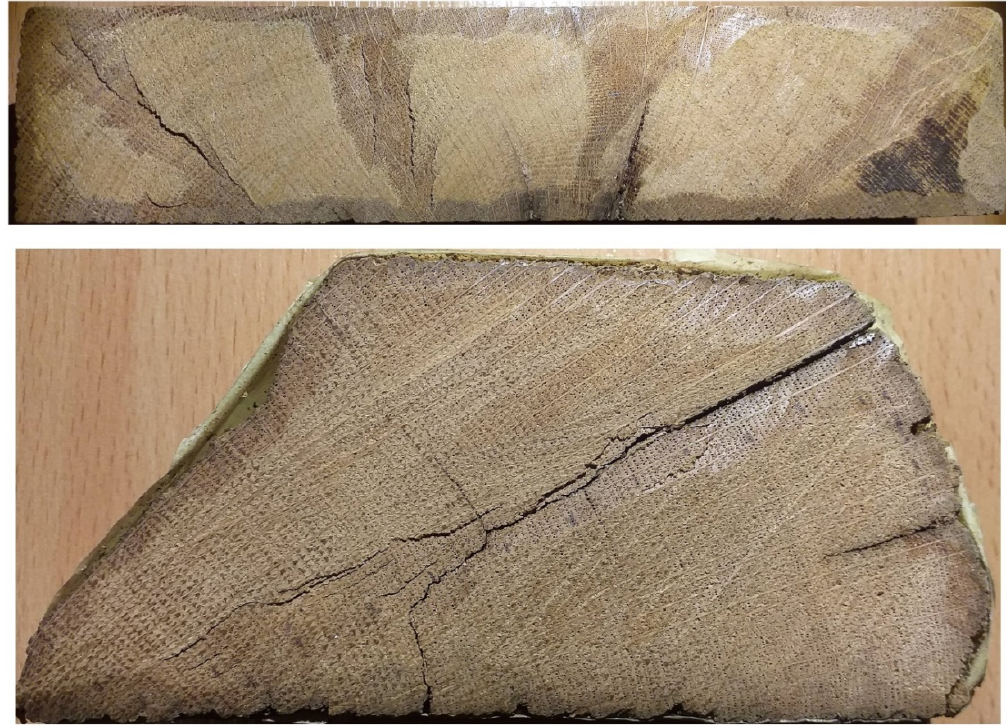
Figure 7. Two of the examined warehouse oak planks with narrow rings but no presence of sapwood rings.